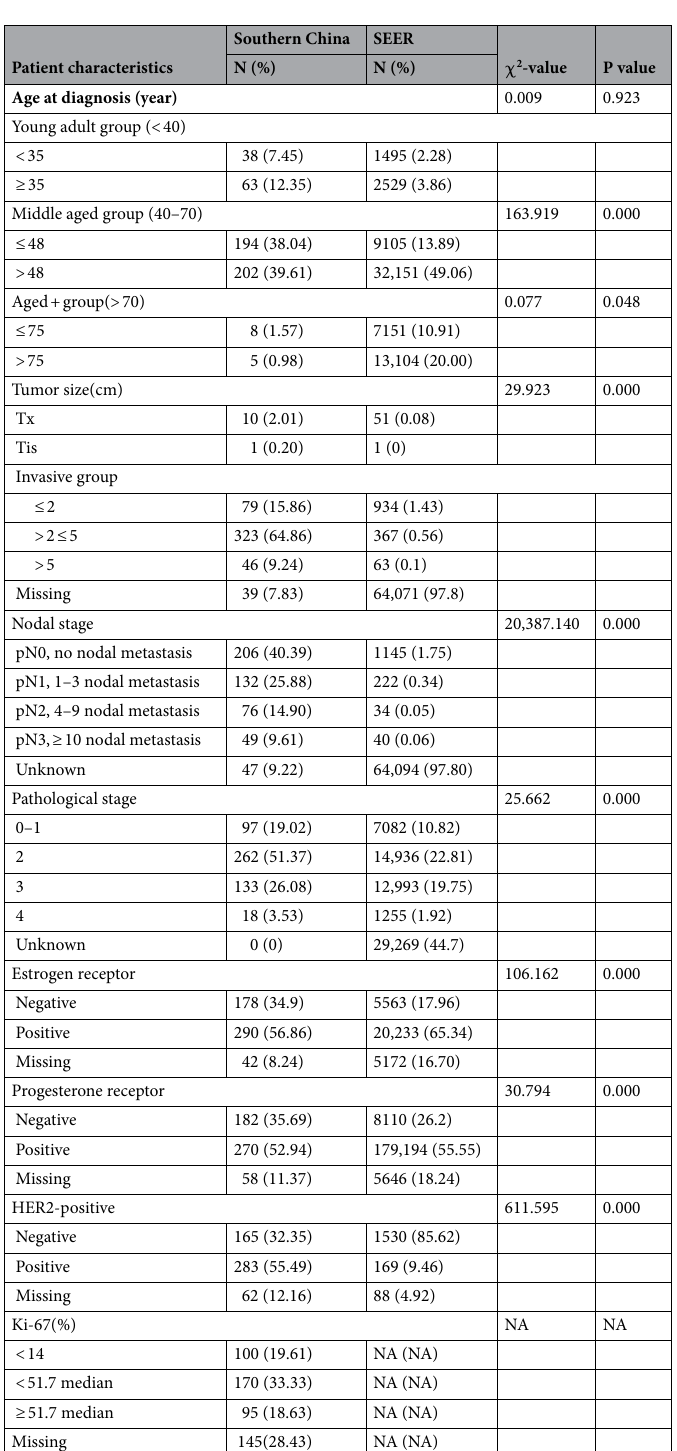
Table 1. Clinicopathologic characteristics of breast cancer patients in Southern China and SEER